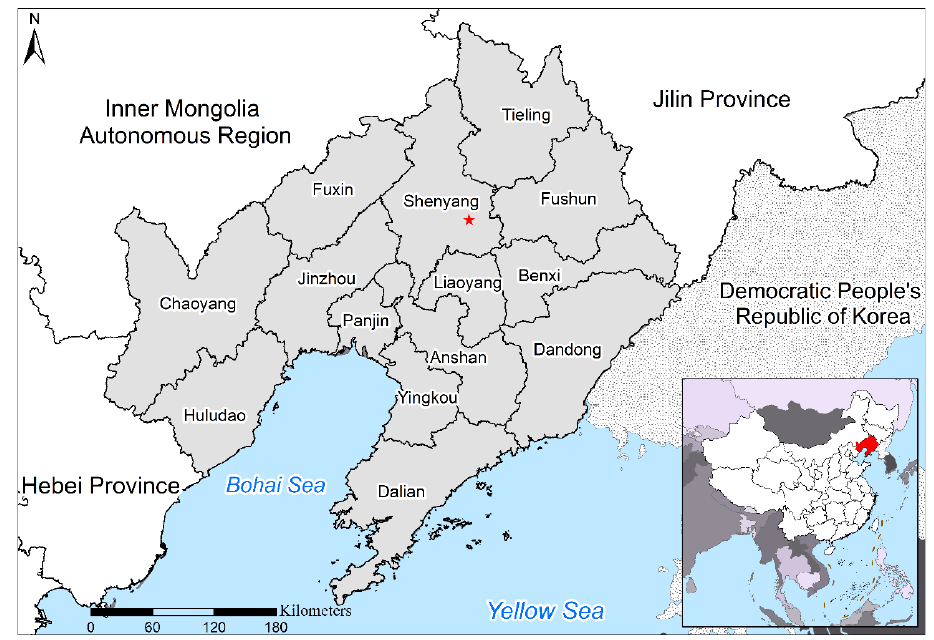
Figure 1. Location and cities in the study area.